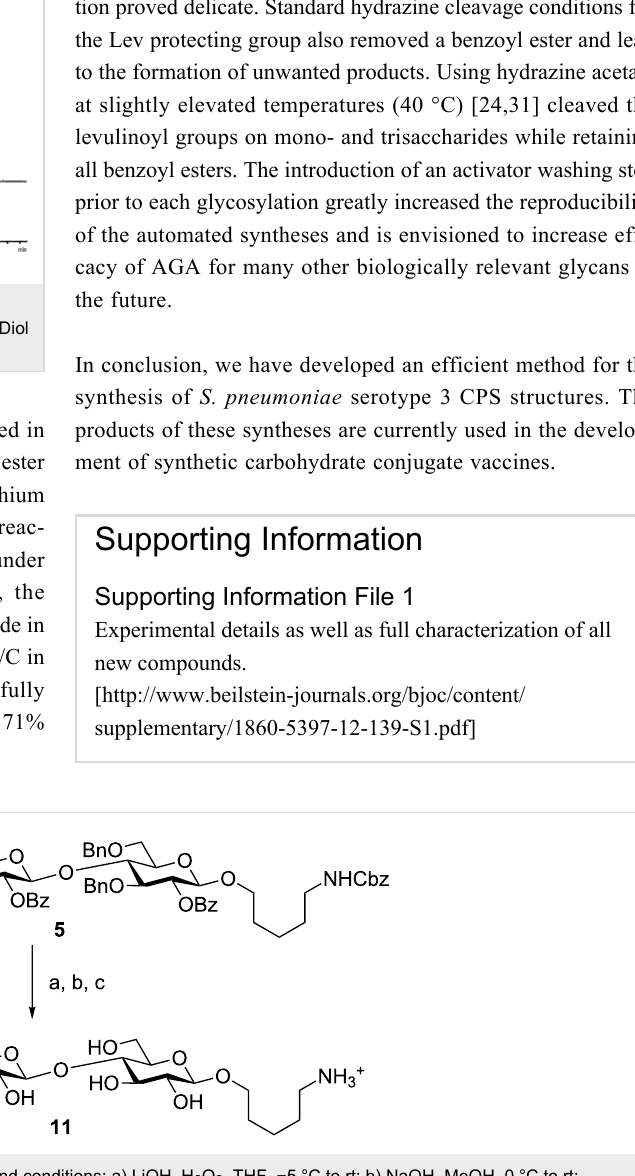
Scheme 5: Global deprotection of SP3 trisaccharide 5 . Reagents and conditions: a) LiOH, H 2 O 2 , THF, − 5 °C to rt; b) NaOH, MeOH, 0 °C to rt; c) Pd(OH)